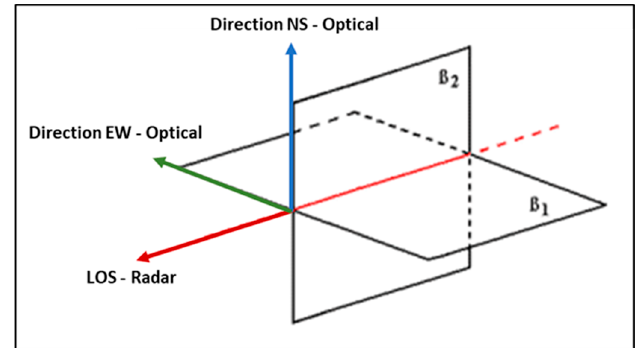
Figure 13. View of David from the camera position.